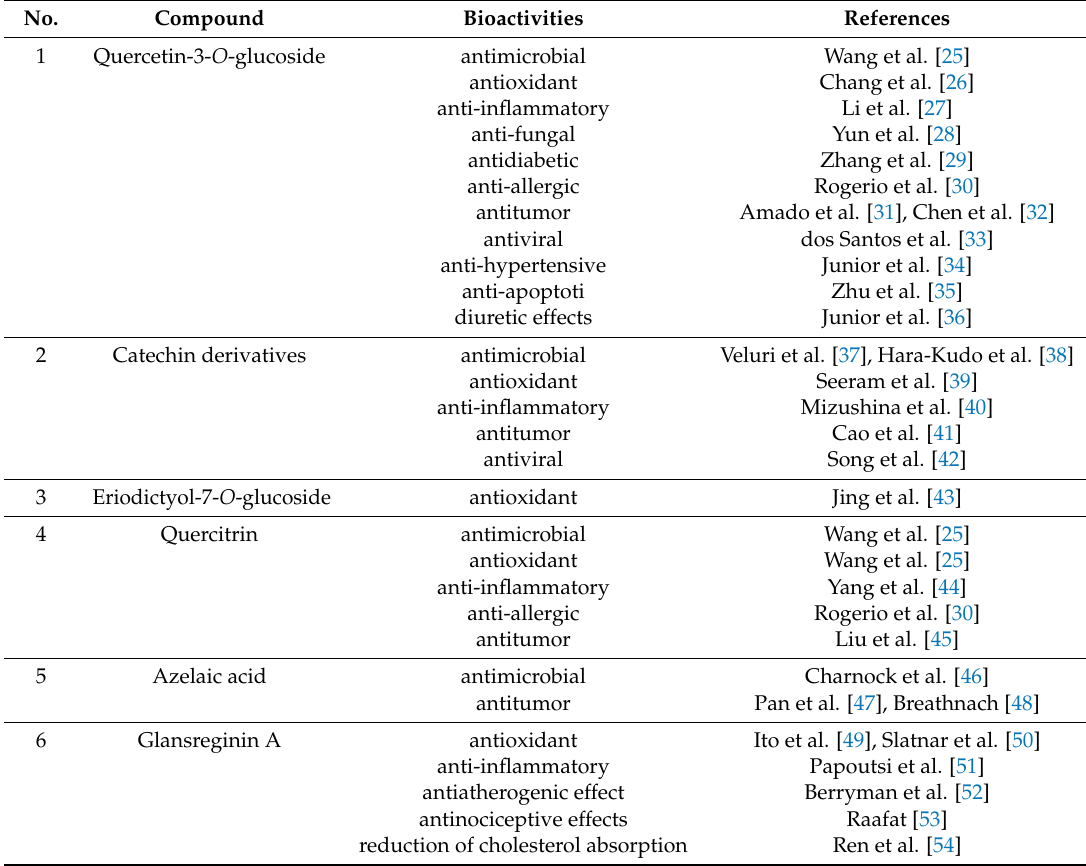
Table 2. Bioactivities of six bioactive compounds responsible for antibacterial activity in the kernels of black walnut